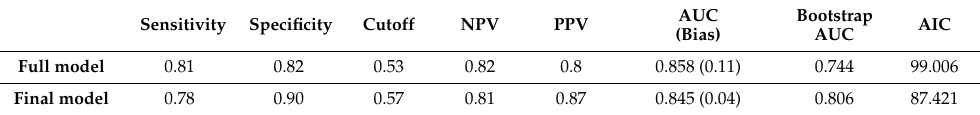
Table 3. Two logistic regression models—comparison of full and final